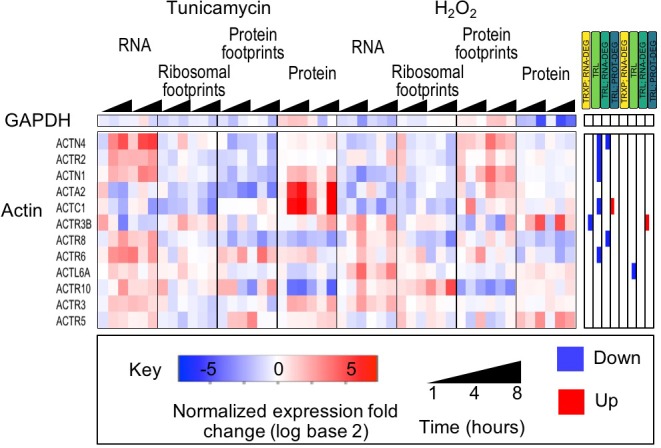
Housekeeping genes are largely unchanged.The heatmap shows the expression data for GAPDH and actin genes. With few exceptions, gene expression is largely unchanged indicating that despite the stress response cells were viable and not undergoing apoptosis.